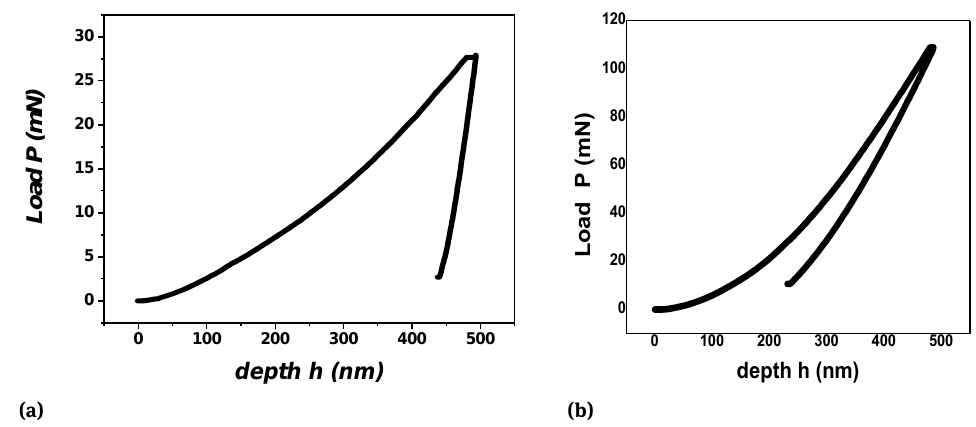
Figure 14: Load-depth curve for bare steel and SiCN Coated steel